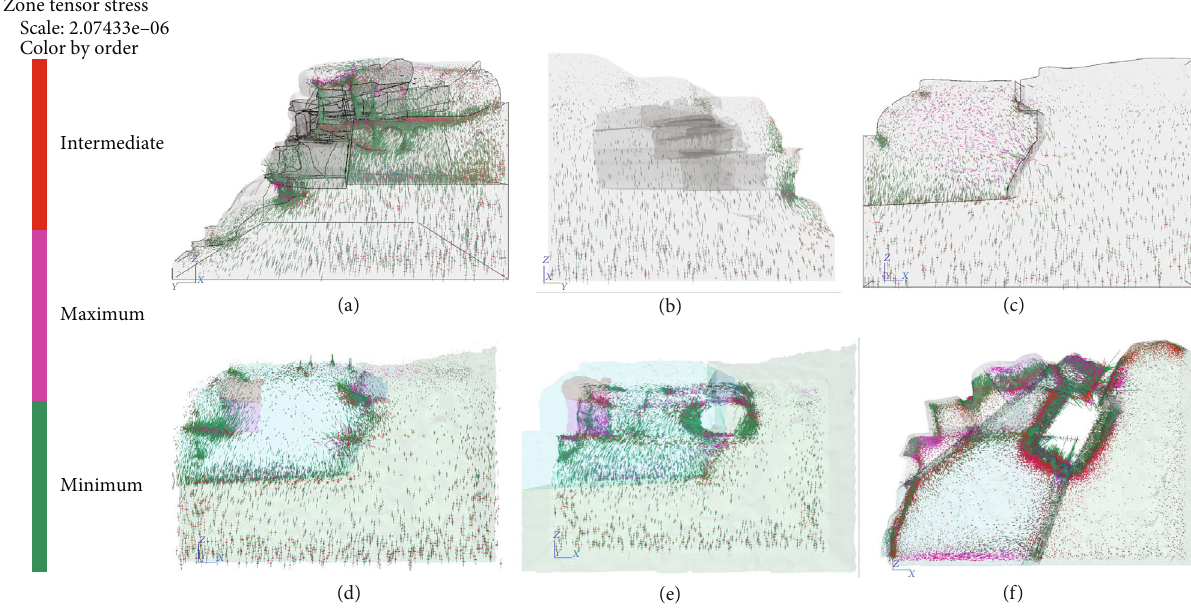
Figure 5: Stress trajectory of surrounding rock: (a) X = 2m ; (b) X = 46m ; (c) Y = 1m ; (d) Y = 5 m ; (e) Y = 15 m ; (f) Z = 15 m